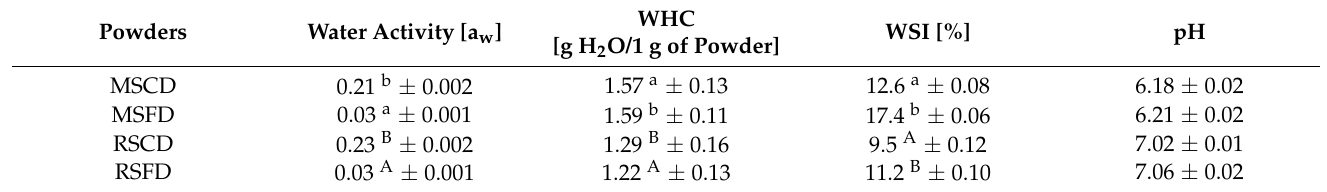
Table 1. Physicochemical properties of mango and rambutan seed powders dried by different